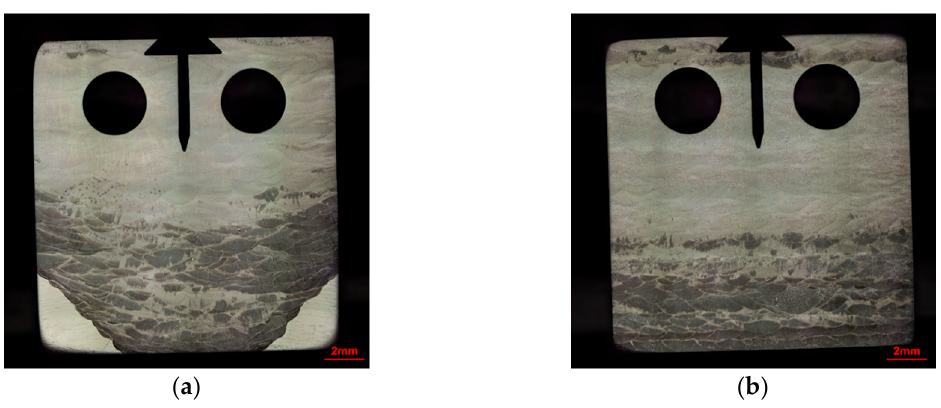
Figure 3. Metallographic diagram of the specimen: ( a ) XY-Z1 specimen and ( b ) XZ1 specimen.